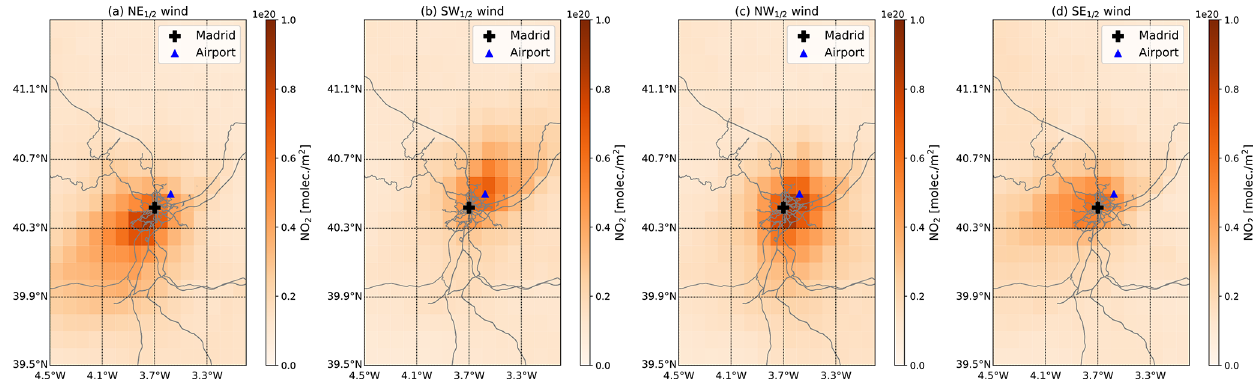
Figure A6. TROPOMI tropospheric NO 2 column for narrow wind regimes covering (a) NE 1 / 2 (0–90 ◦ ), (b) SW 1 / 2 (180–270 ◦ ), (c) NW 1 / 2